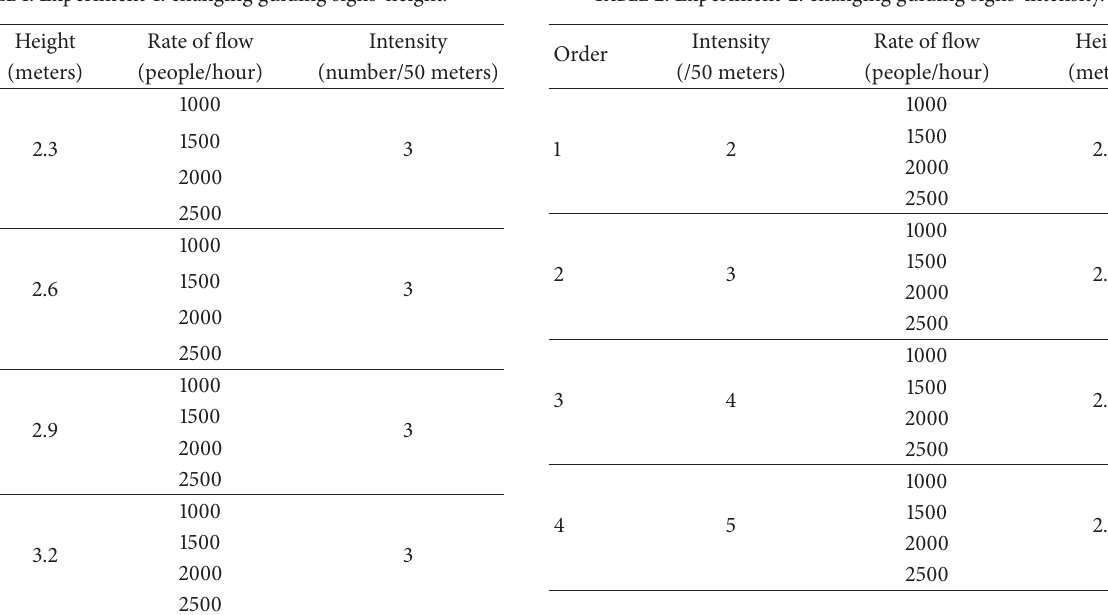
Table 1: Experiment 1: changing guiding signs’ height. Table 2: Experiment 2: changing guiding signs’